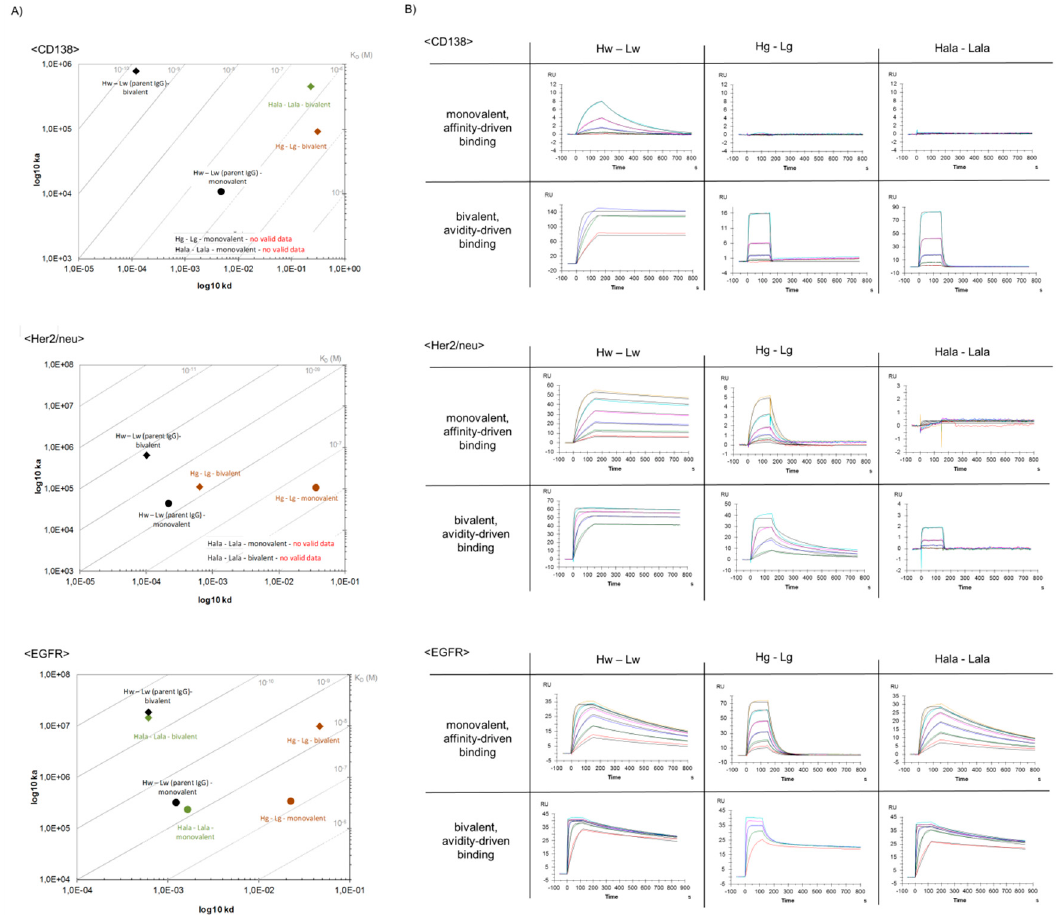
Figure 6. Comparison of binding kinetics and SPR profiles of B2GL variants vs. alanine replacement variants. Shown are ( A ) on-/off-rate plots and ( B ) SPR profiles based on affinity-mediated and avidity-mediated binding kinetics.